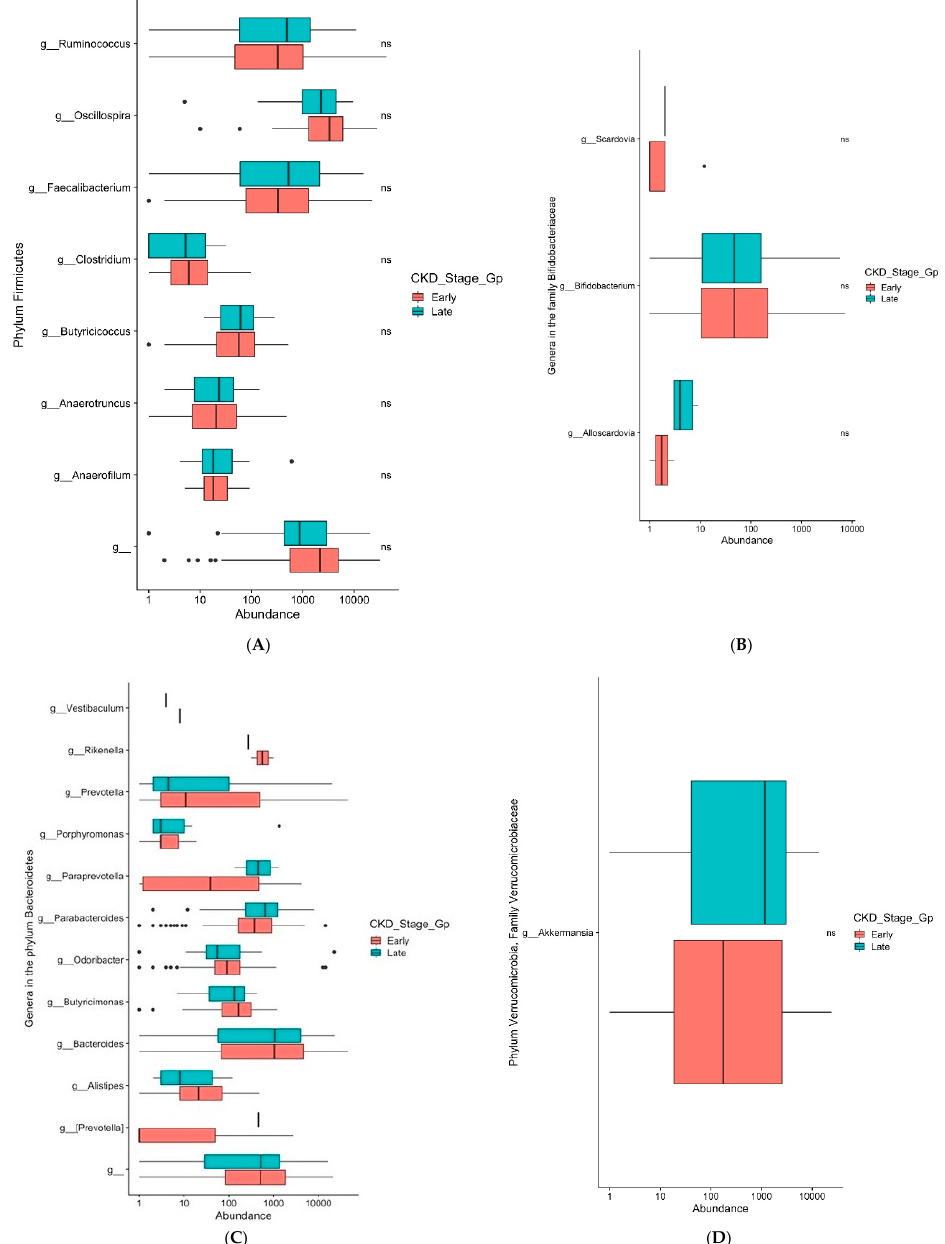
Figure 5. ( A ): Box and whiskers plots display a relative abundance of genera Ruminococcus and Faecalibacterium between early and late CKD groups . ns denotes non significance. ( B ): Box and whiskers plots display relative abundance of genus Bifidobacterium between early and late CKD groups . ns denotes non significance. ( C ): Box and whiskers plots display rela- tive abundance of genus Bacteroides between early and late CKD groups . ( D ): Box and whiskers plots display relative abundance of genus Akkermansia between early and late CKD groups . ns denotes non significance.